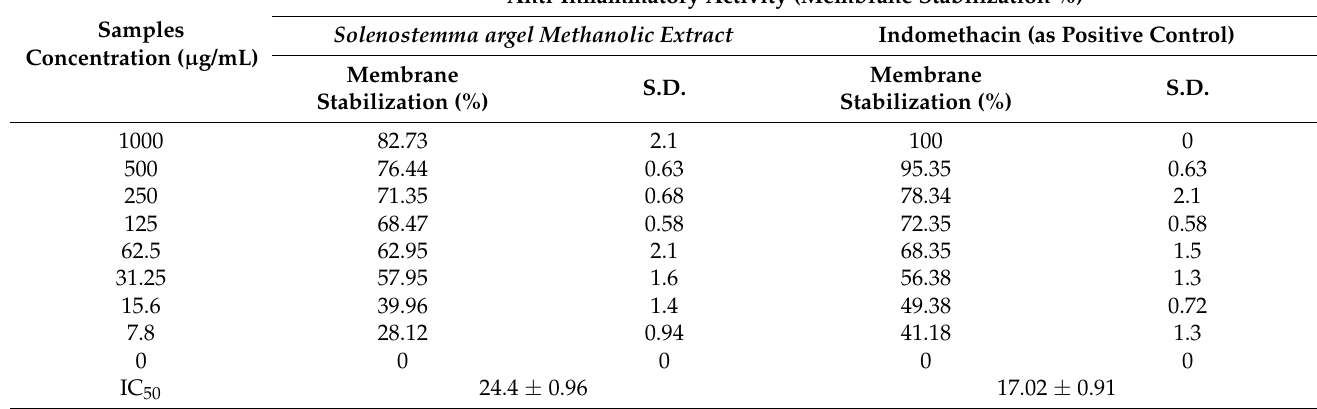
Table 6. Anti-inflammatory activity (membrane stabilization %) of Solenostemma argel methanolic extract at different concentrations.